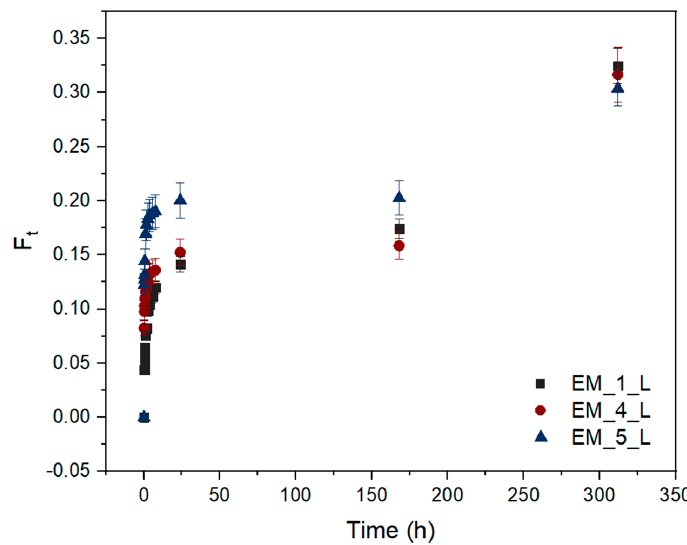
Figure 5. Cumulative fractional release of levofloxacin from electrospun films EM_1_L, EM_4_L and EM_5_L. (F t —fraction of drug released in t time. The data points and error bars represent mean values and standard deviation of data sets, respectively).